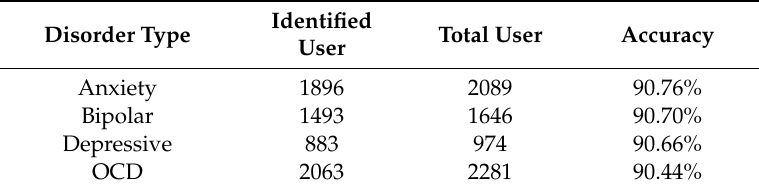
Table 7. Evaluation on the diagnosed-oriented